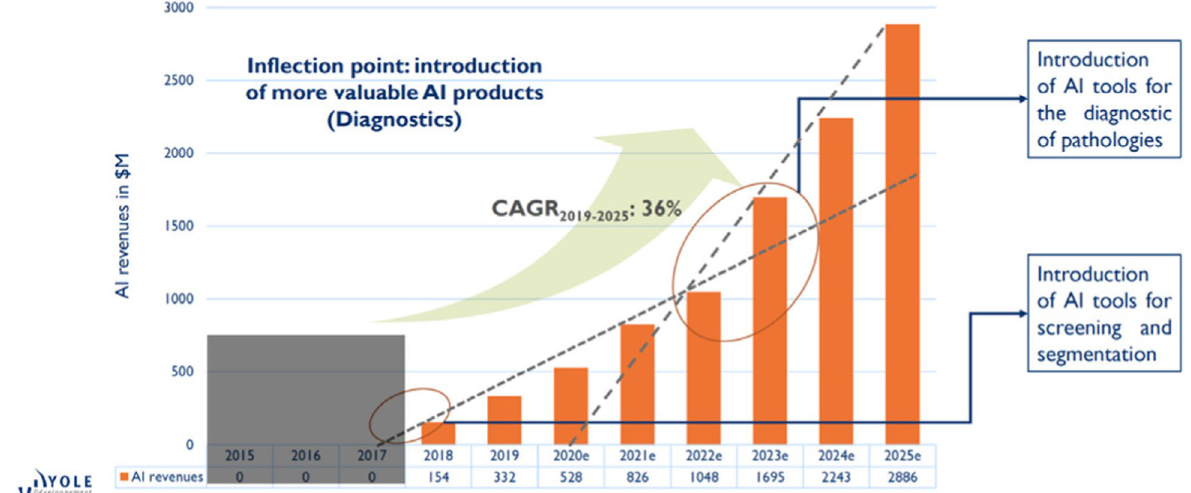
Fig. 1 AI revenue of the medical imaging companies from 2015 to 2025 (adapted from www. yoleg roup.